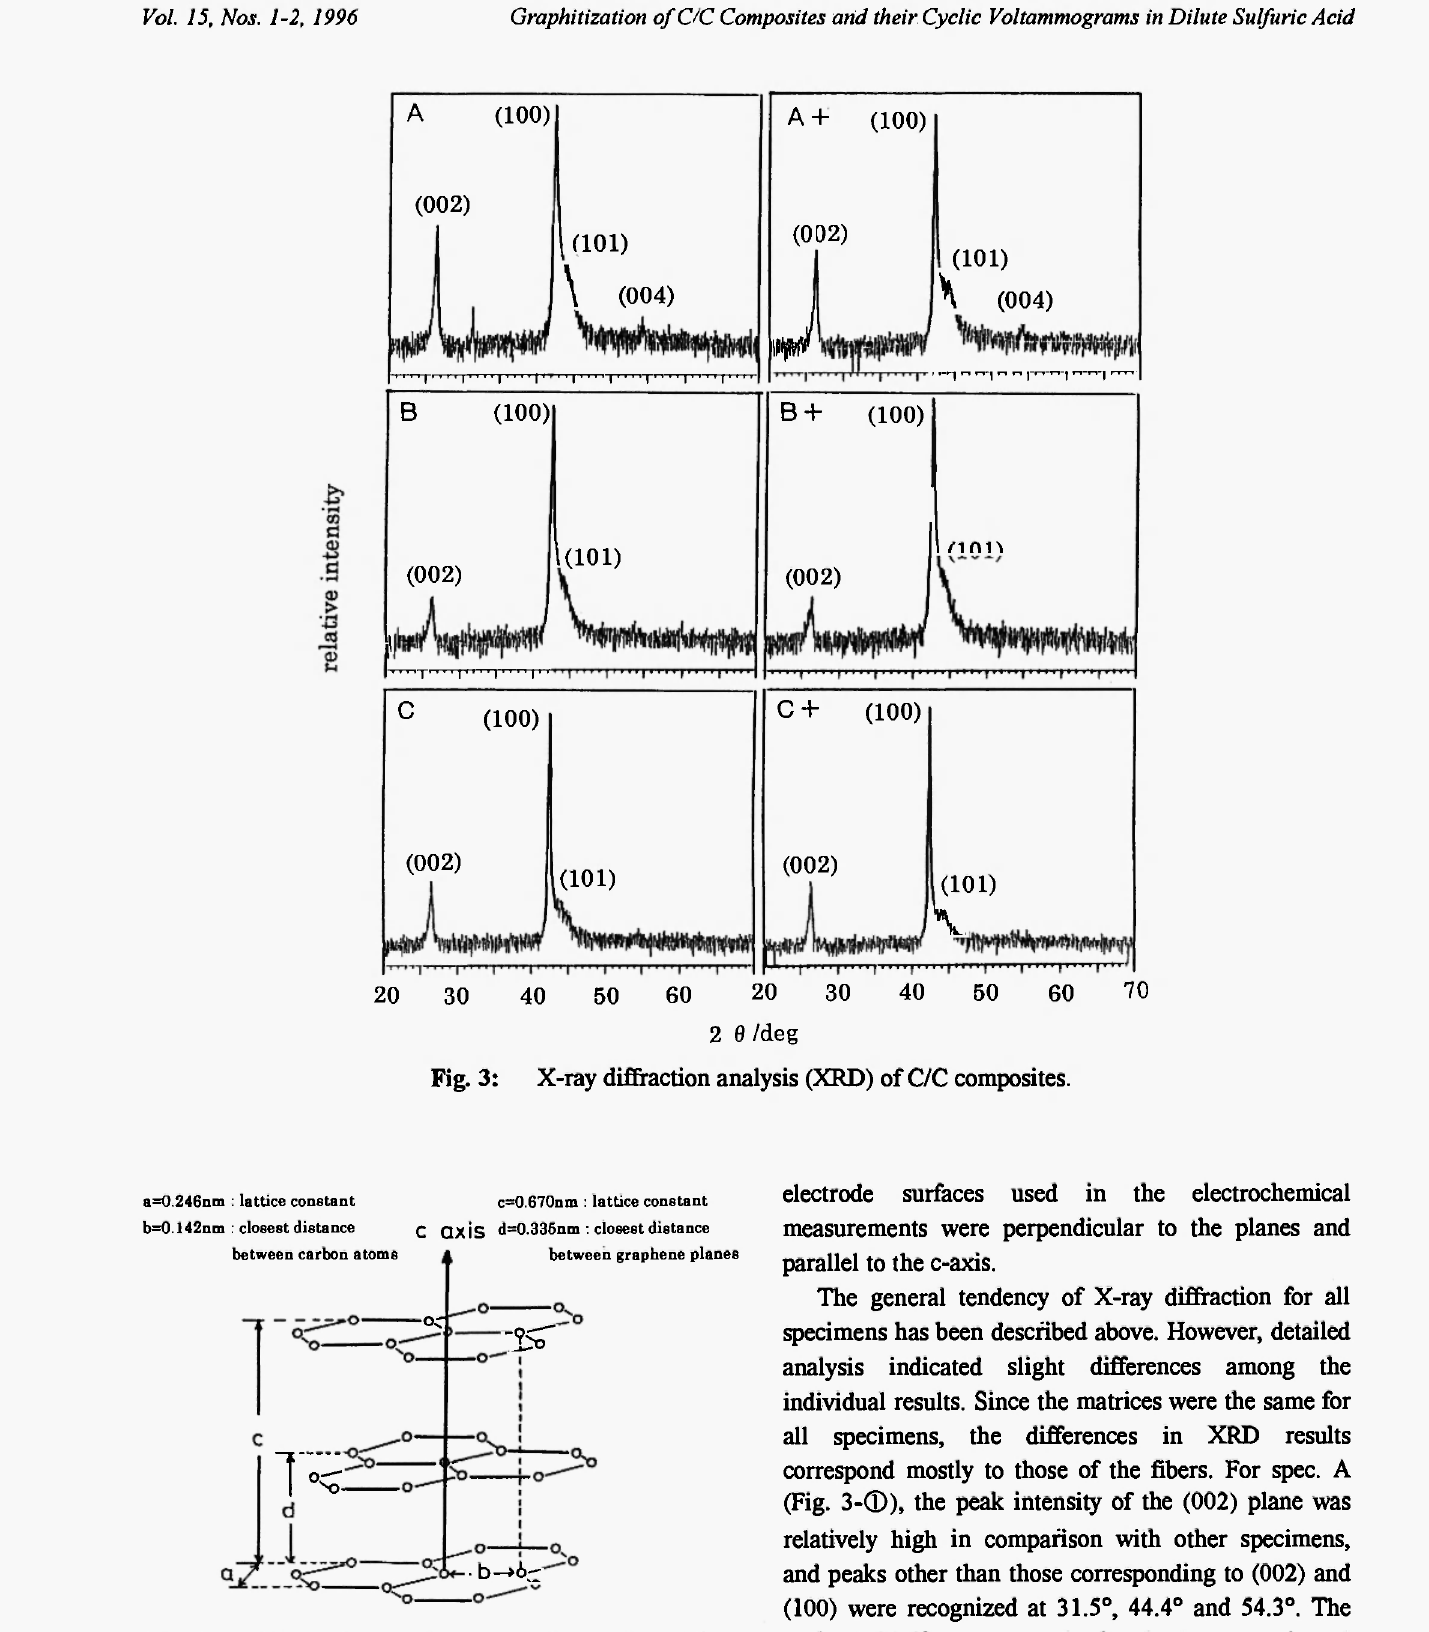
Fig. 4: Schematic crystal structure of natural graphite.